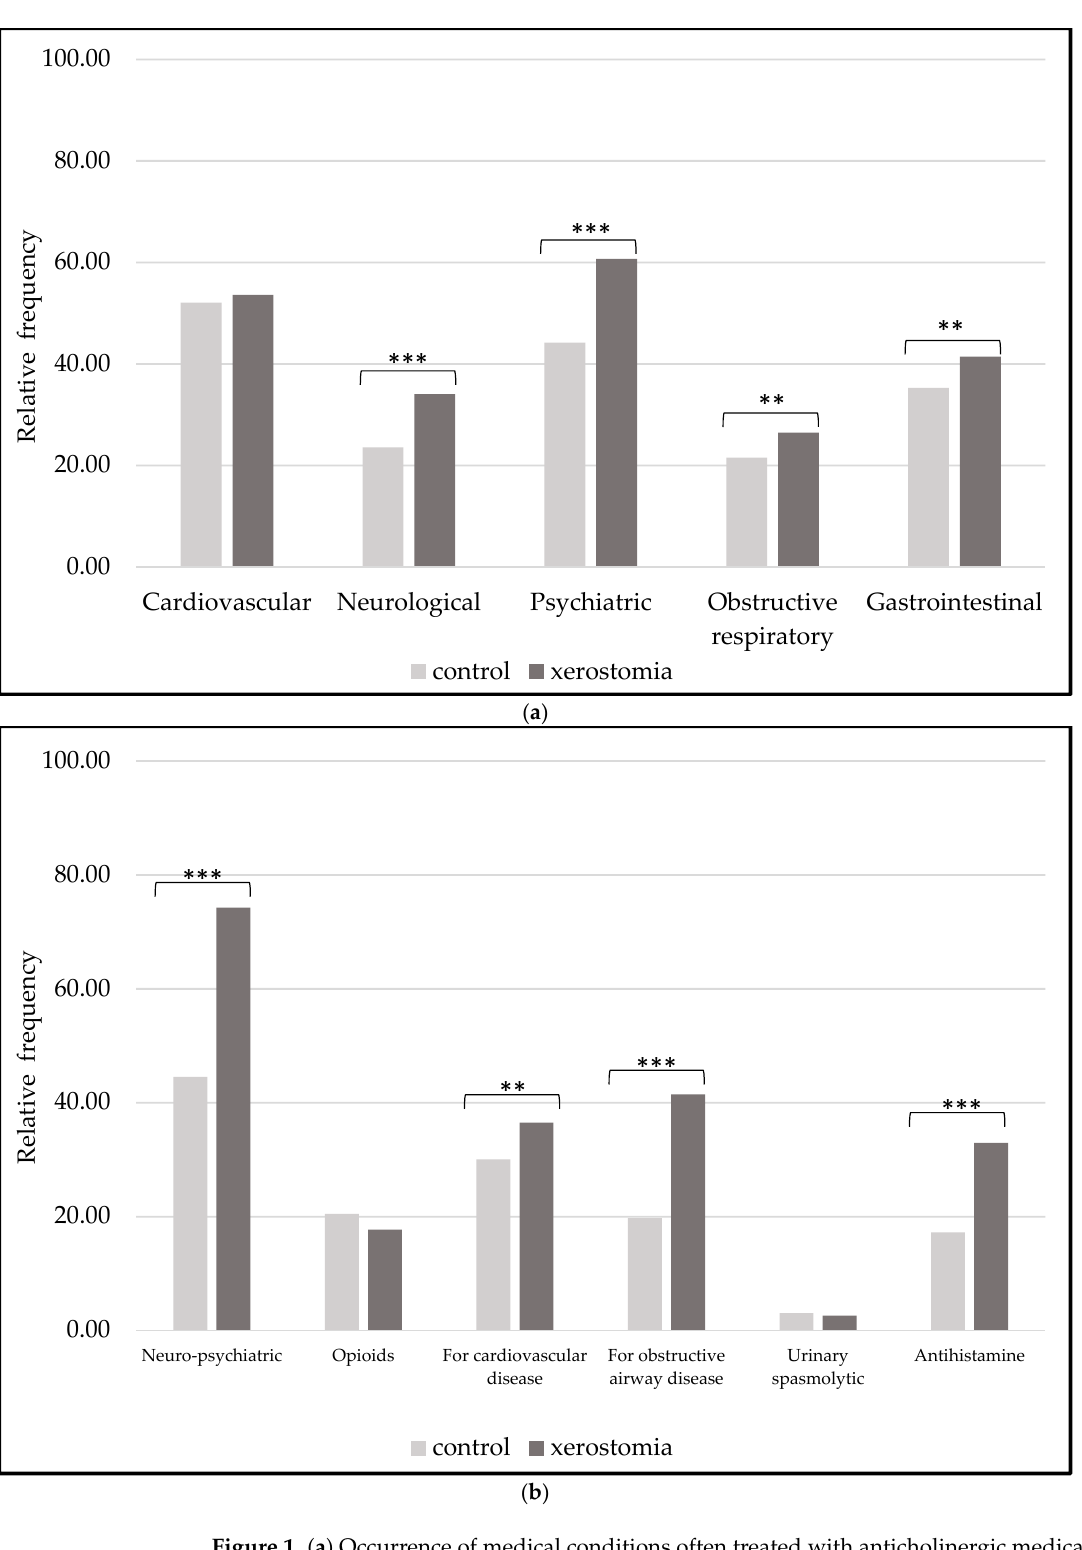
Figure 1. ( a ) Occurrence of medical conditions often treated with anticholinergic medications in the case and control groups. ( b ) Most frequent classes of medications with anticholinergic properties ( (cid:2031) 2 test comparisons with ** p -value < 0.05 and *** < 0.001). Statistically significant differences in neurological, psychiatric, obstructive respira- tory, and gastrointestinal diseases show higher frequencies in the xerostomia group. We